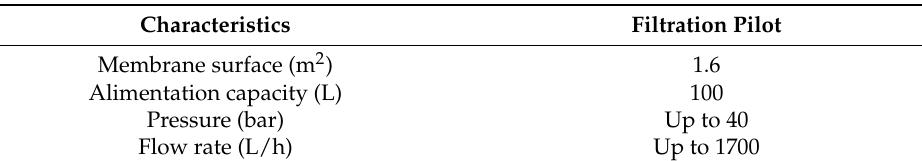
Table 1. Characteristics of the nanofiltration pilot.